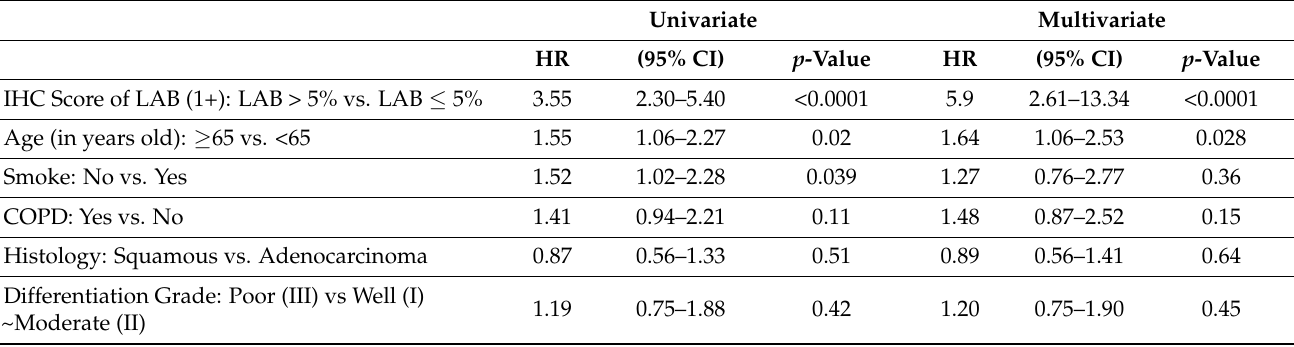
Figure 4. High LAB expression was associated with poor prognosis in NSCLC patients. ( A ) Kaplan– Meier curves of overall survival were stratified by LAB expression score (0, 1, 2, and 3). ( B ) Kaplan– Meier curves of overall survival were stratified by LAB expression (negative vs. positive). Table 1. Univariate and multivariate analysis of major prognostic factors for overall survival using Cox proportional hazards models in cohort 2. Variables significant in univariate analyses were included in multivariate analysis and further selected by backward